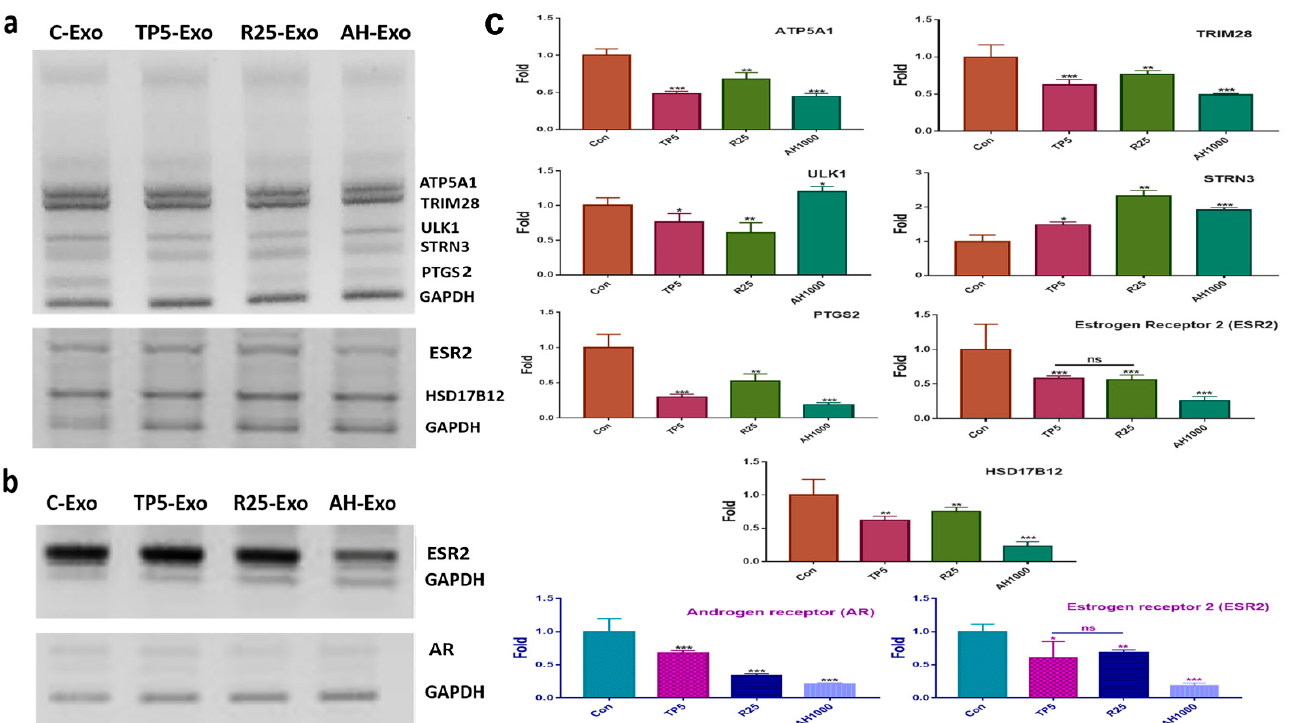
Figure 4. Effects of induced exosomes on various parameters associated with endometrial cancer (EC) cells; ( a ) Effects of miRNAs on biochemical marker levels. ( b ) Effects of miRNAs on ovarian cancer cells; 5 µg/mL tocopherol- α (TP5), 25 µg/mL rutin (R25), and 1000 µg/mL A. helianthus extract (AH1000). ( c ) Histograms for the a and b panels. C-Exo, exosomes from EC cells; TP5-Exo, exosomes from TP5-treated EC cells; R25-Exo, exosomes from R25-treated EC cells; AH-Exo, exosomes from AH1000-treated EC cells. ns: not significant; * p < 0.05; ** p < 0.01; *** p < 0.001.